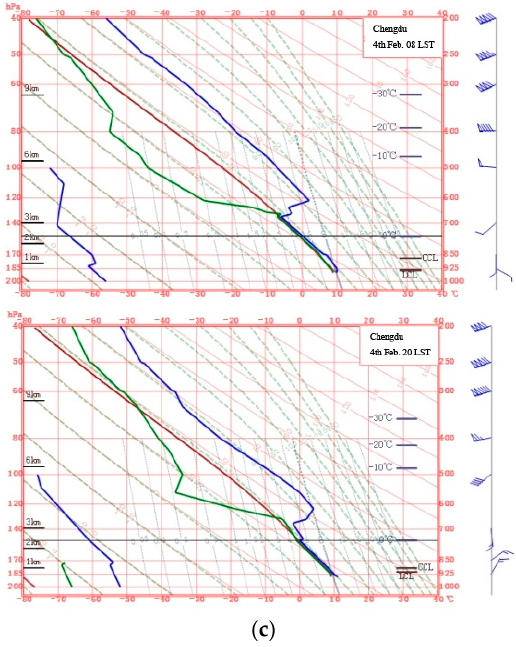
Figure 7. ( a ) T-(-lnP) diagram at 08 and 20 LST on the 26th of January; ( b ) T-(-lnP) diagram at 08 and 20 LST on 31st of January; ( c ) T-(-lnP) diagram at 08 and 20 LST on the 4th of February. Horizontal axis and ordinate represent temperature (°C) and height (km), respectively. The blue curve on the far right of the graph represents the change of the temperature with height. Where the temperature increases with height (the slope below 90°), an inversion layer must exist.